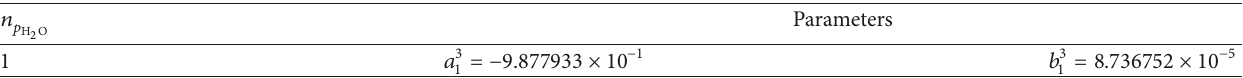
= 1 calculated by the first algorithm. H 2 O